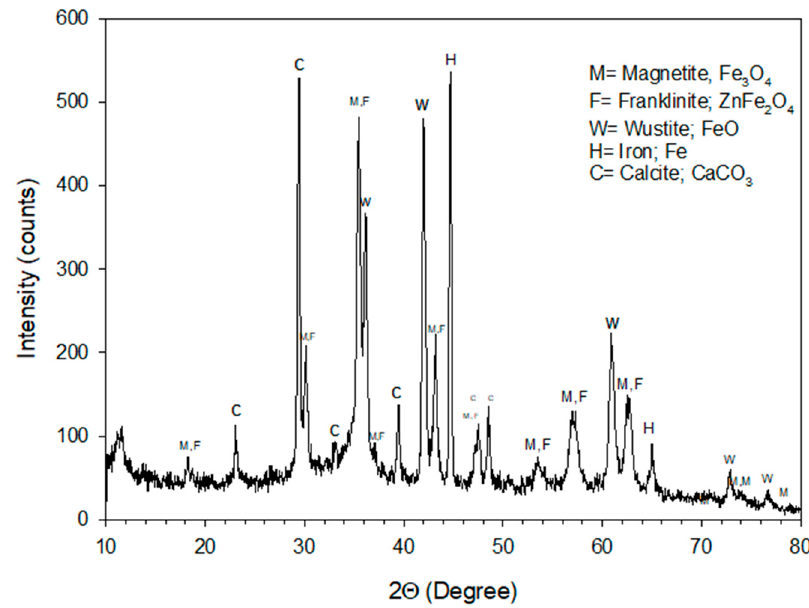
Figure 1. X-Ray di ff raction pattern obtained for the Figure 1. X-Ray diffraction pattern obtained for the BFS.